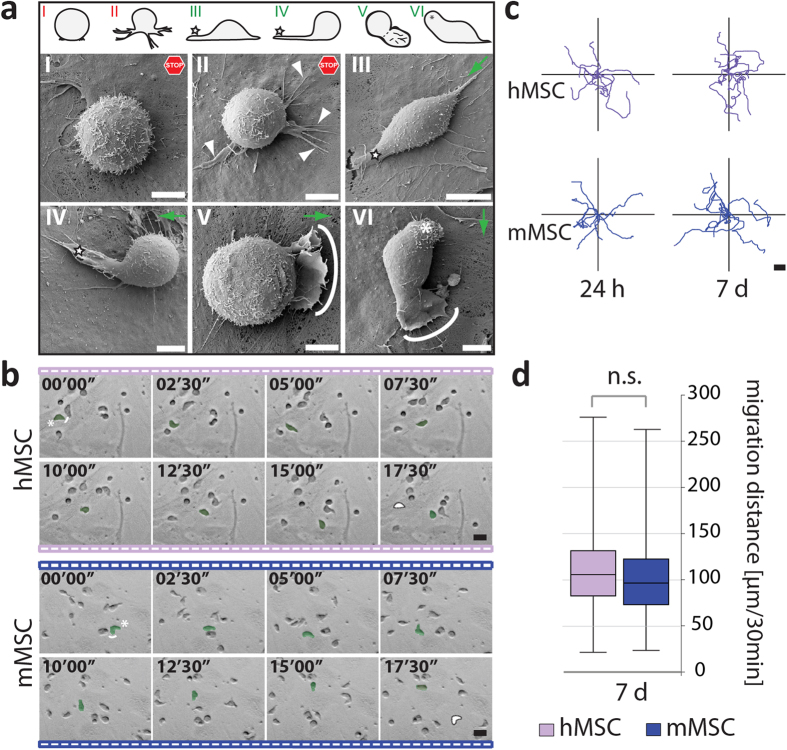
Polarization and migration of human HSPCs growing on murine or human MSCs.(a) Human (h) HSPCs growing on murine (m) MSCs for 7 days were analyzed by SEM. Six cellular shapes are depicted (top panel, models I-VI) with the corresponding photographs (middle and bottom panels). Adherent hematopoietic cells were either round with microvilli on their surface (I) or displayed large plasma membrane protrusions such as filopodium (II, arrowhead), magnupodium (III-IV, star) and lamellipodium (V, solid line). They could also develop a uropod at the rear pole (VI, asterisk). Models I-II show non-migrating cells (stop) whereas models III-VI exemplify migrating ones. Green arrows represent the direction of migration. (b) Individual frames taken from a time-lapse video show a hHSPC (green) moving on the surface of h or mMSCs after 24 hours of co-culture. Asterisk and white line indicate the rear and front pole of a migrating hHSPC, respectively (first frame). White spot marks its starting point (last frame). The elapsed time is shown in the upper-left corner. (c) Tracking diagrams depict the movement of 10 cells for 30 min. They were tracked after 24 hours and 7 days of co-culture on MSCs. (d) Box-and-whisker plots show the migration distance within 30 min of cells cultured on MSCs for 7 days. The boxes represent data from 25th–75th percentiles and 100% within the whiskers. Horizontal lines within the box represent median values. 100 cells were counted per condition (n = 3; CD34+ HSPCs were isolated from distinct donors and cultured on two different MSC preparations). No significant (n.s.) difference was observed as calculated by two-tailed paired student’s t-test (p ≥ 0.05). Scale bars: 5 μm (a), 20 μm (b,c).